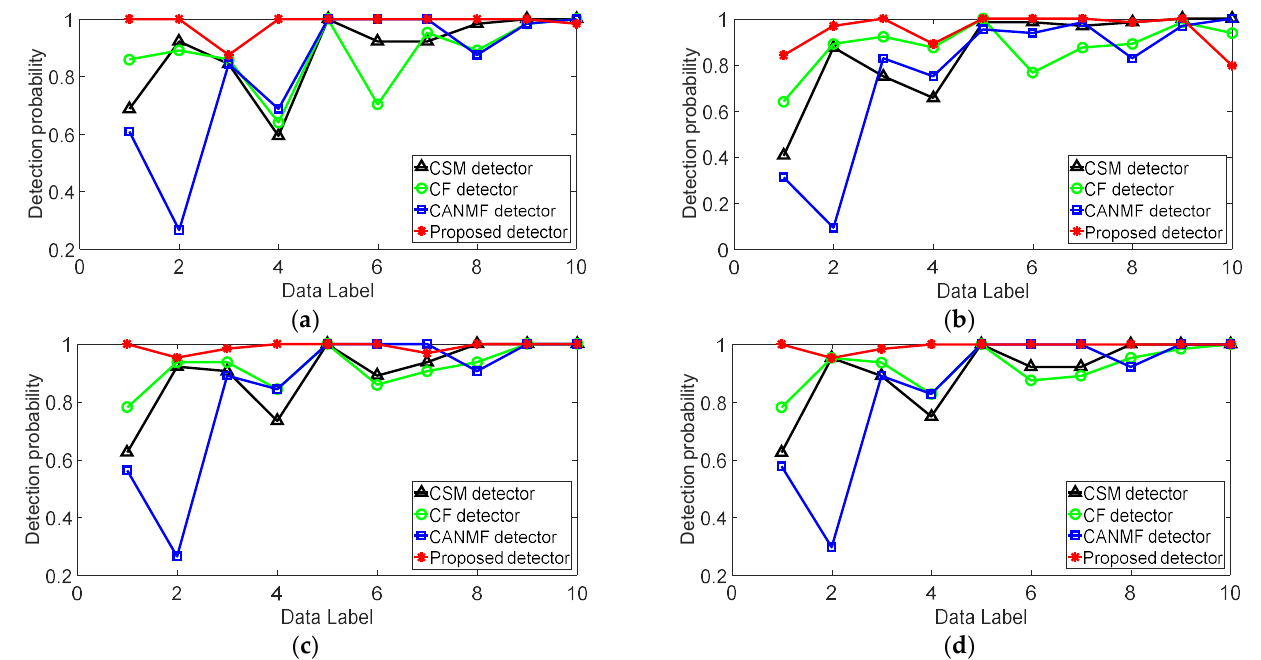
Figure 13. Target detection results of IPIX-1993 dataset. ( a ) HH. ( b ) HV. ( c ) VH. ( d ) VV.